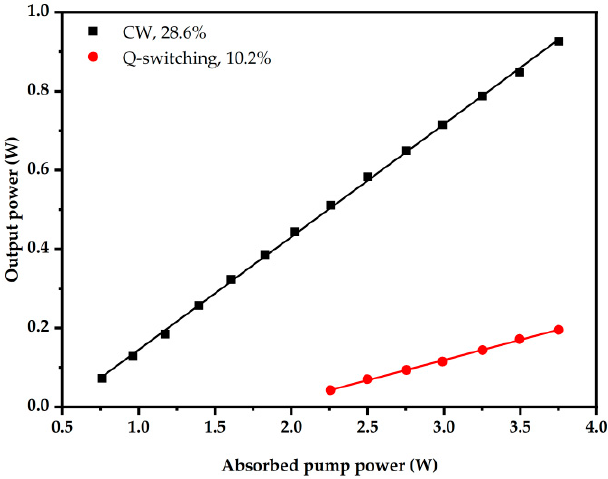
Figure 5. The average output power of Nd:GYAP laser in different operation regimes.